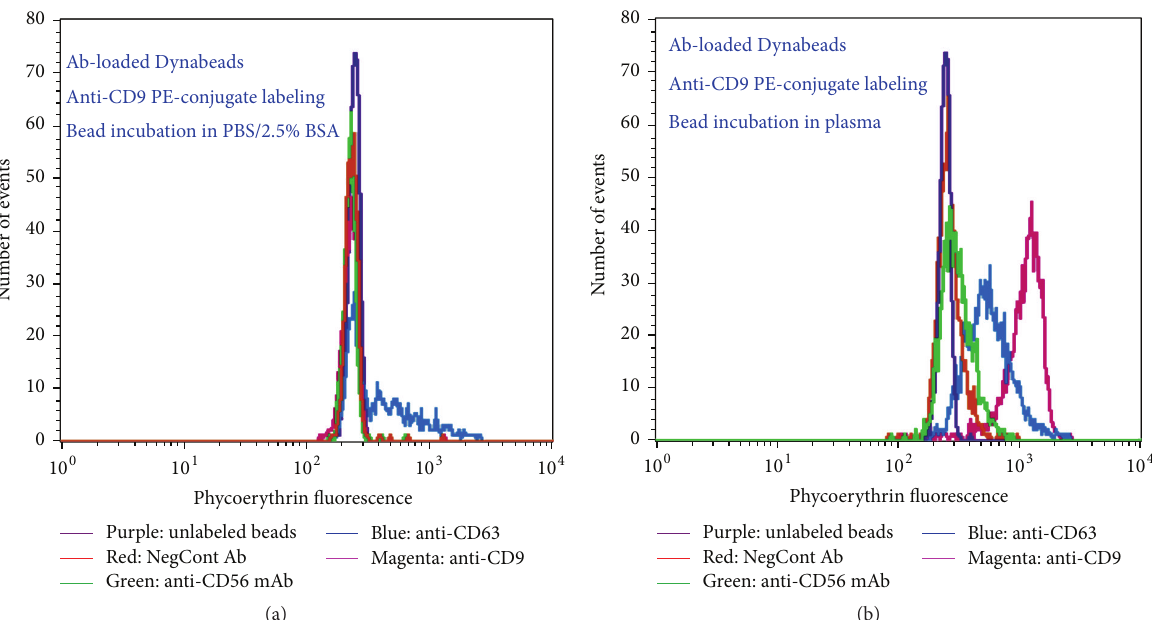
Figure 4: Flow cytometry histograms showing ability to specifically enrich nsEVs from plasma using streptavidin-coated Dynabeads loaded with biotinylated Abs. After plasma incubation, magnetic particles were labeled with phycoerythrin- (PE-) conjugated anti-CD9 Ab. The 𝑦 -axis denotes number of magnetic particle events counted by flow cytometer. The 𝑥 -axis denotes phycoerythrin (PE) fluorescence. Legends under histograms denote biotinylated Abs loaded onto magnetic particles. (a) corresponds to analysis of magnetic particles incubated with PBS/2.5% BSA rather than plasma; these histograms show that PE-conjugated anti-CD9 Ab has little or no propensity to nonspecifically bind Ab-loaded magnetic